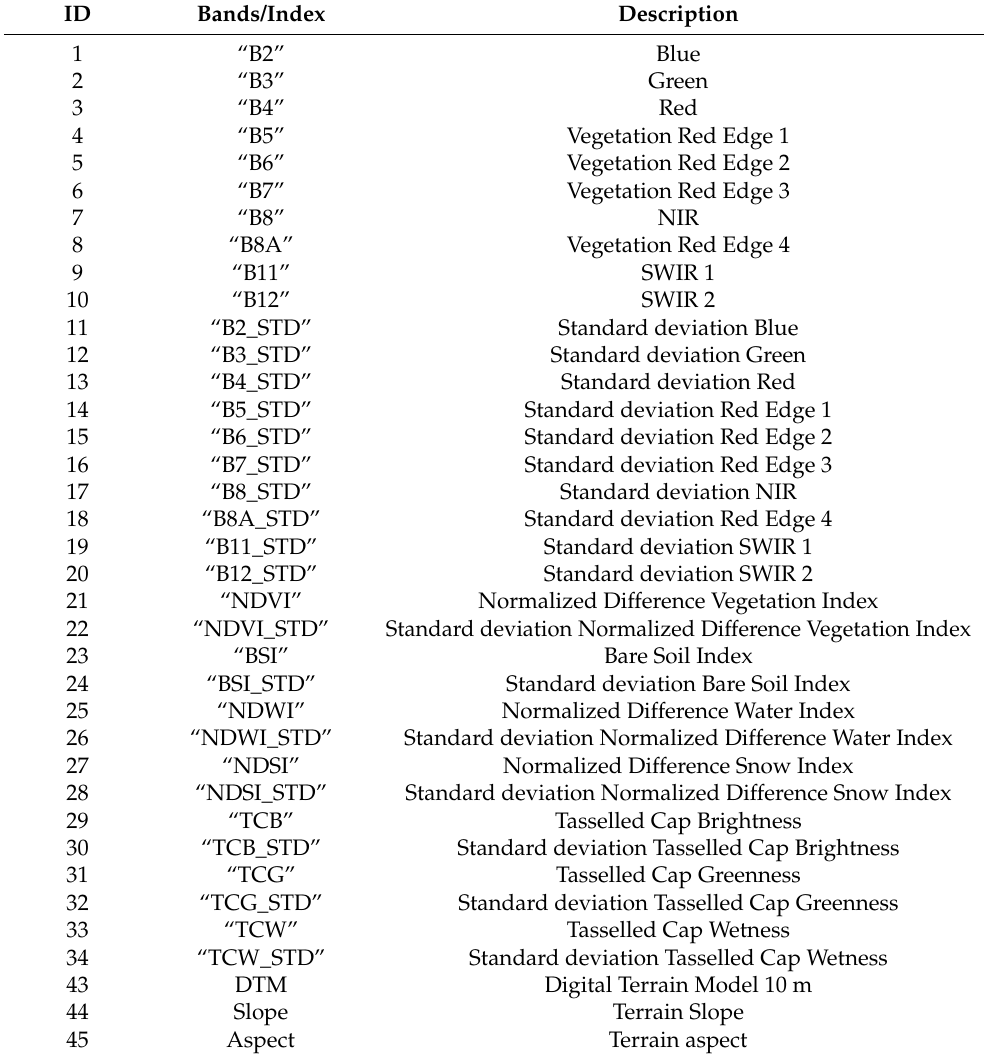
Table 4. Composition of the input multispectral datasets in the mountain areas